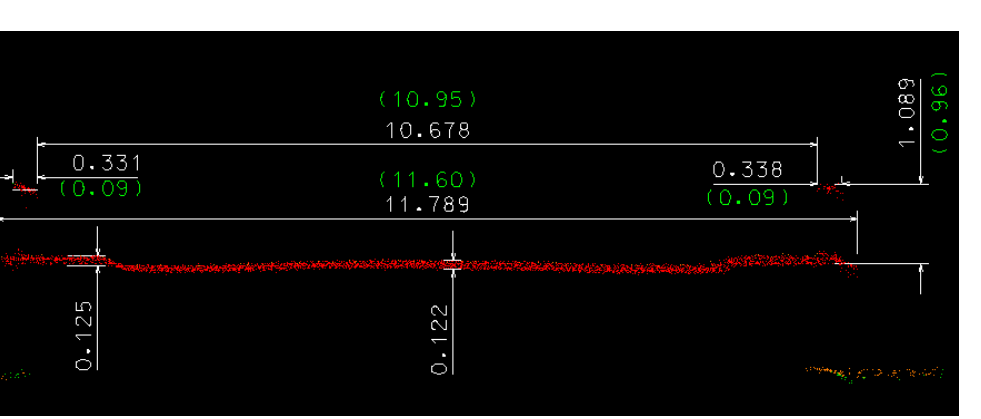
Figure 8. Comparison of the road bridge dimensions obtained from the scanned point cloud in TerraScan software ( white color ) and from the real measurement ( green color ).